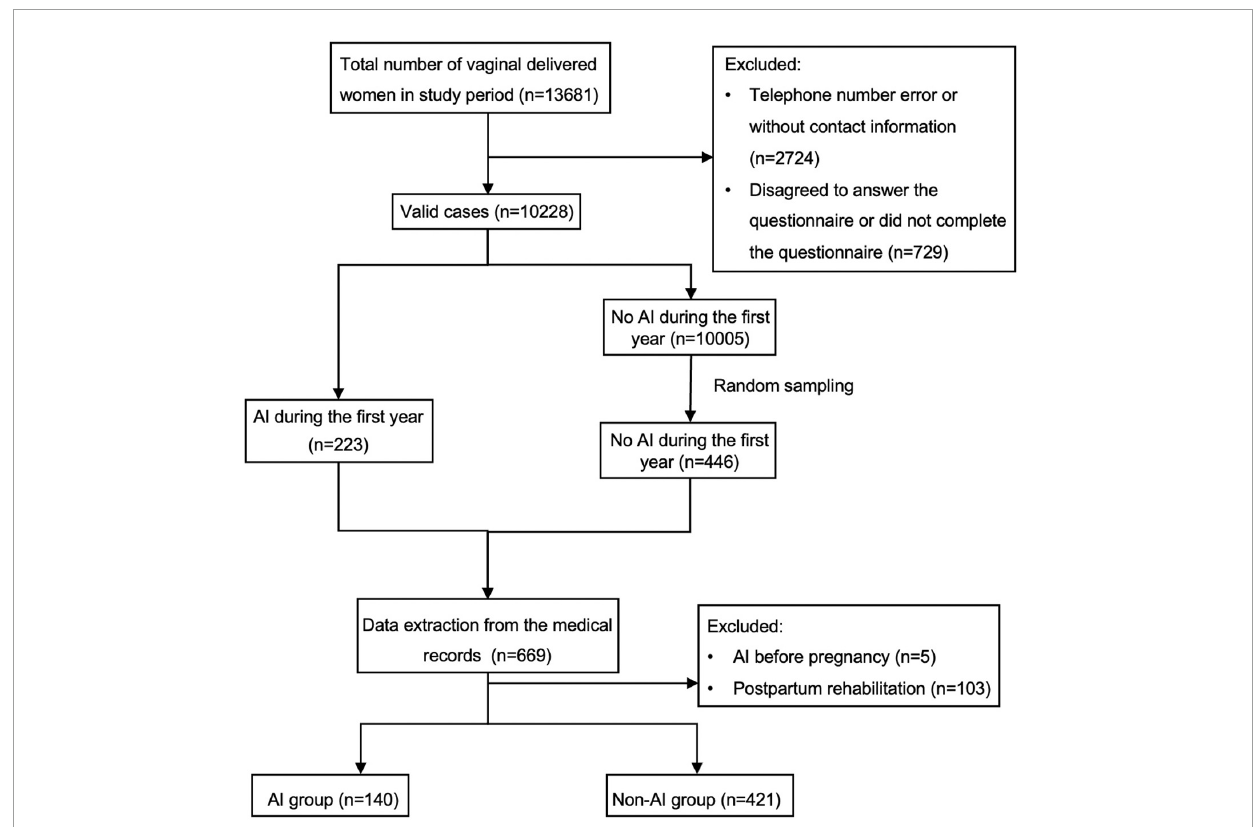
FIGURE1 Flowchat of participants through the study. The two groups consisted of vaginal delivered women at Peking University Third Hospital between January 1, 2014 and June 30, 2018 consecutively, except those who didn’t get contact information or complete a valid questionnaire. The presence of anal incontinence (AI) was determined based on a Jorge and Wexner score greater than 0. The control group was randomly selected from women with a score of 0, and the number of control group participants was twice that of the study group. Women who had AI before pregnancy or pelvic floor rehabilitation postpartum were also